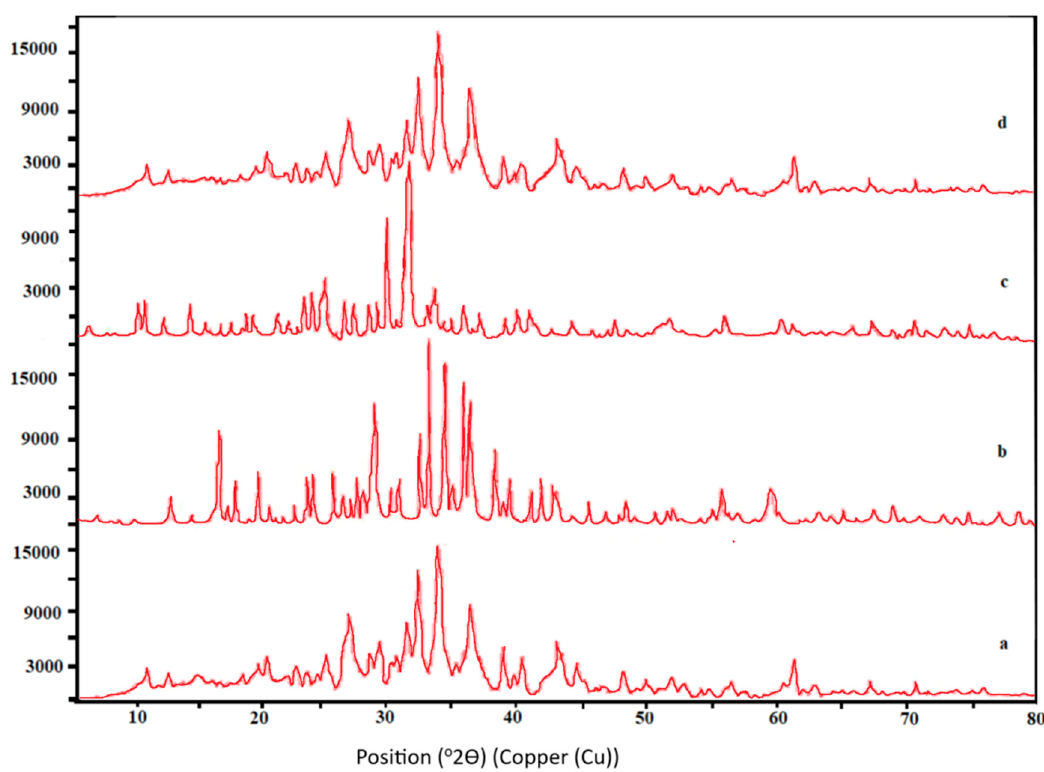
Figure 5. TheX-ray patterns of zeolites. Zeolites: a—natural; zeolite with the maximum content of the cations: b—In 3+ ; c—In 3+ and Ga 3+ ; d—zeolite with the minimum content of the In 3+ and Ga 3+ cations.